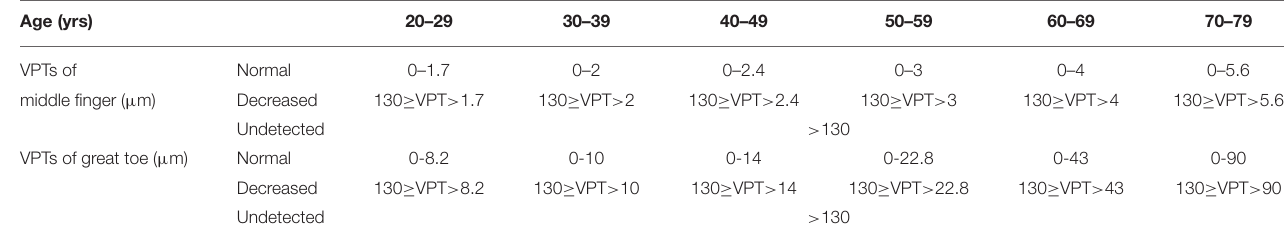
TABLE 2 | Vibration perception thresholds (VPTs) of